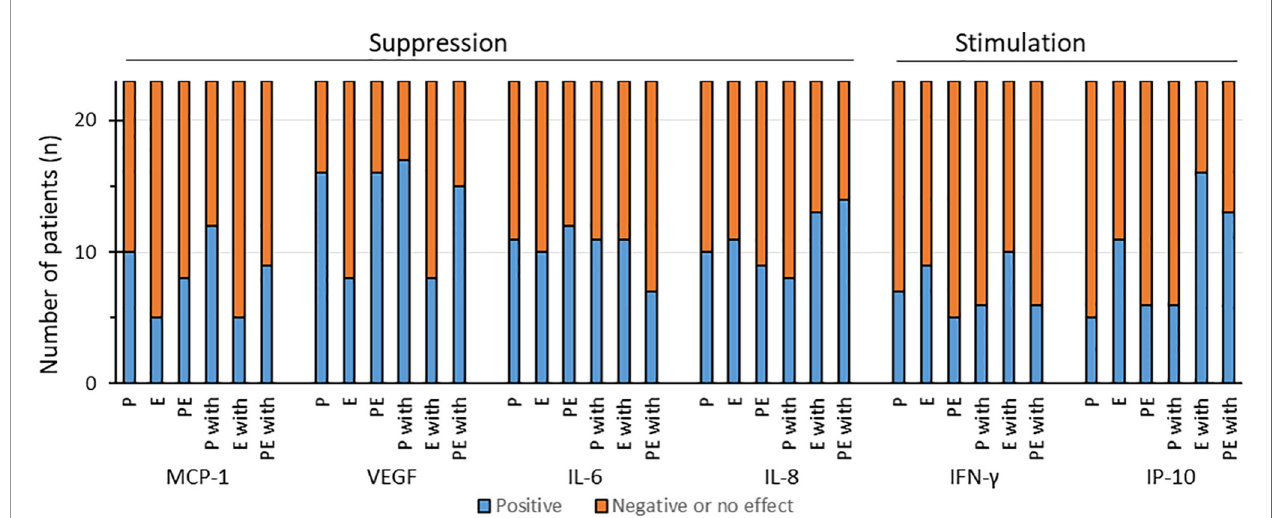
FIGURE 2 | Distribution of the effects of pembrolizumab ( P ), cetuximab ( E ), and pembrolizumab plus cetuximab ( PE ) alone or with IFN- g ( P with , E with , or PE with , respectively) on the cytokine production of individual HNSCC samples. We de fi ned as positive effect either the signi fi cantly suppressed production of monocyte chemoattractant protein 1 (MCP-1), vascular endothelial growth factor (VEGF), interleukin 6 (IL-6), and IL-8 or the signi fi cant increased production of interferon gamma (IFN- g ) and interferon gamma-induced protein 10 (IP-10) through synergism or